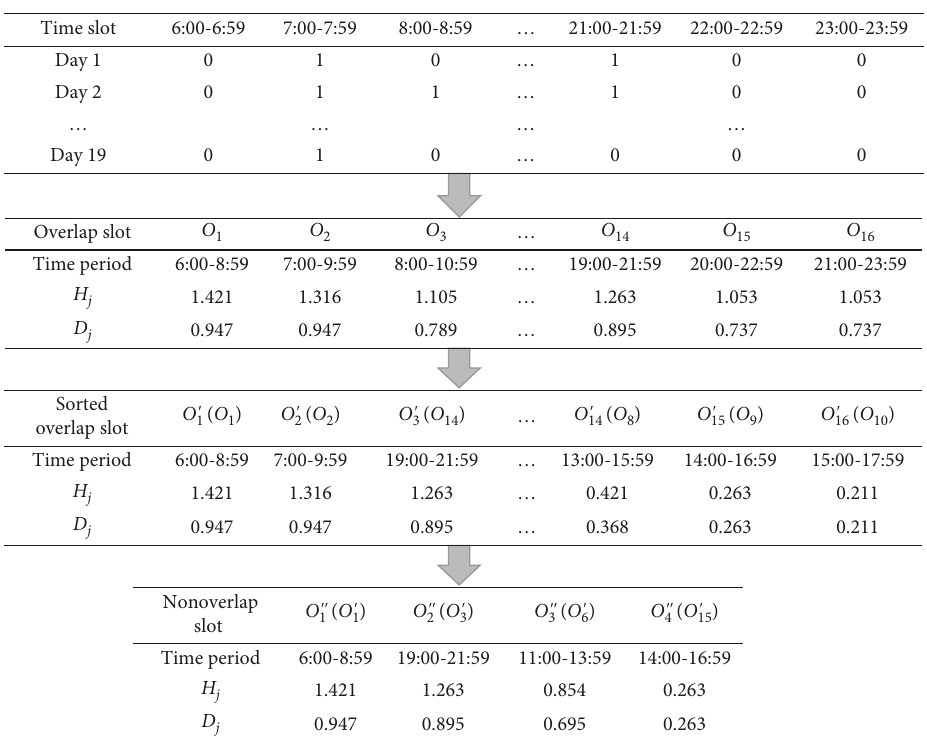
Figure 4: Illustration of the generation of nonoverlap